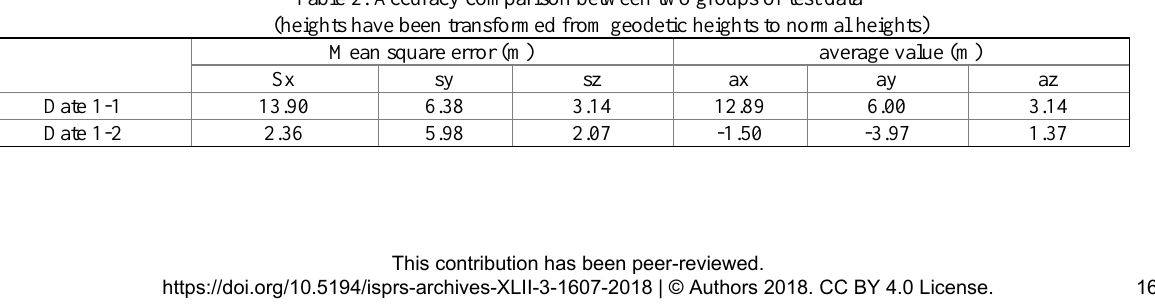
Table 2: Accuracy comparison between two groups of test